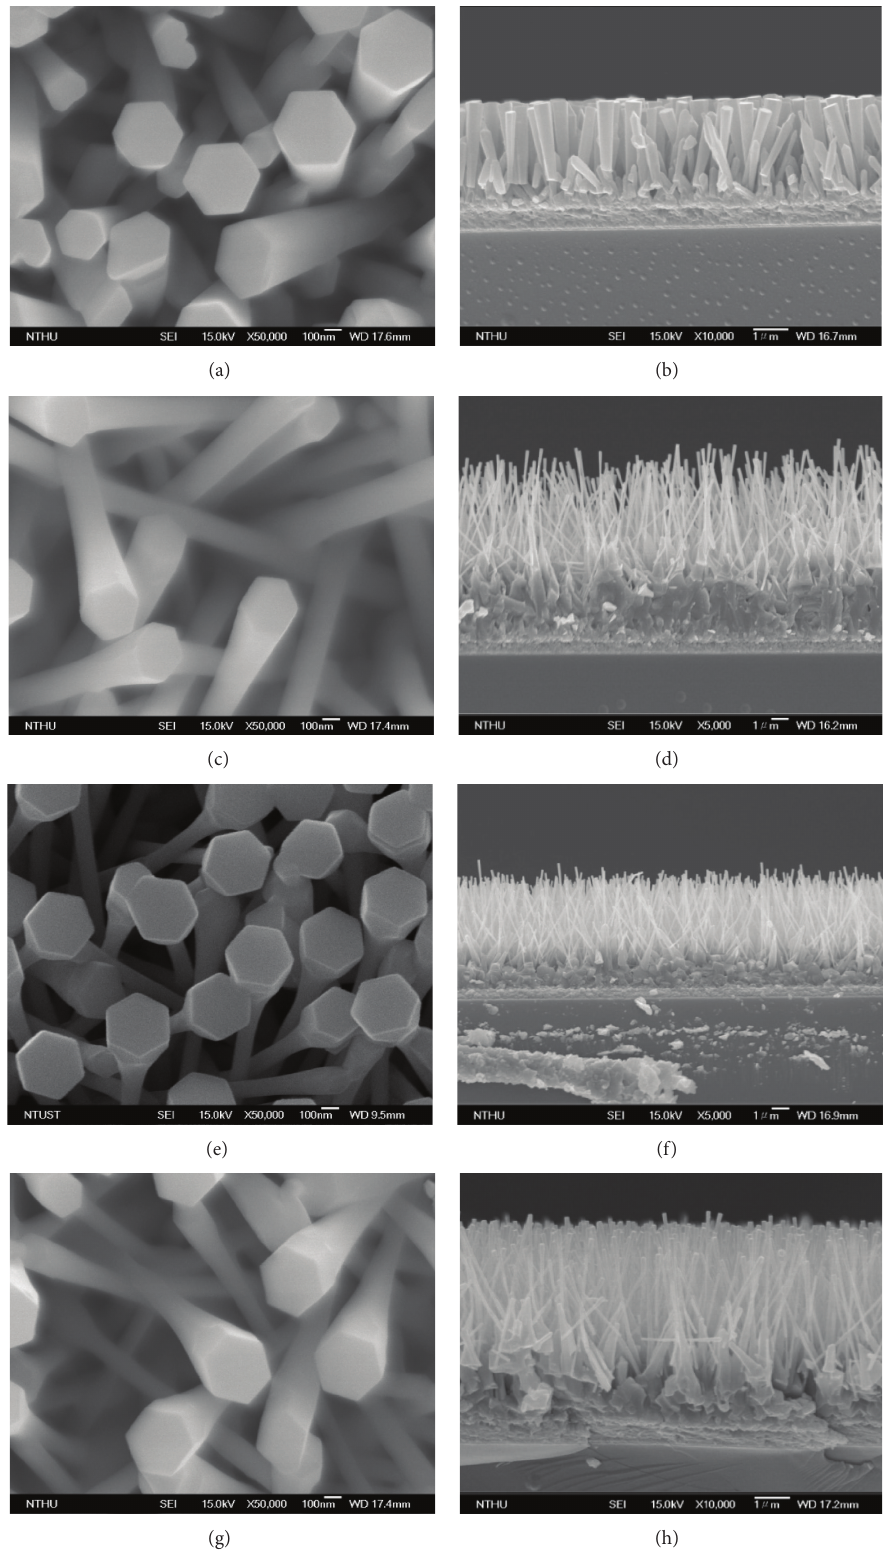
Figure 2: FE-SEM images of ZnO nanowires on the FTO conducting glass with different growth times: (a)-(b) for 30 minutes, (c)-(d) for 60 minutes, (e)-(f) for 90 minutes, and (g)-(h) for 120